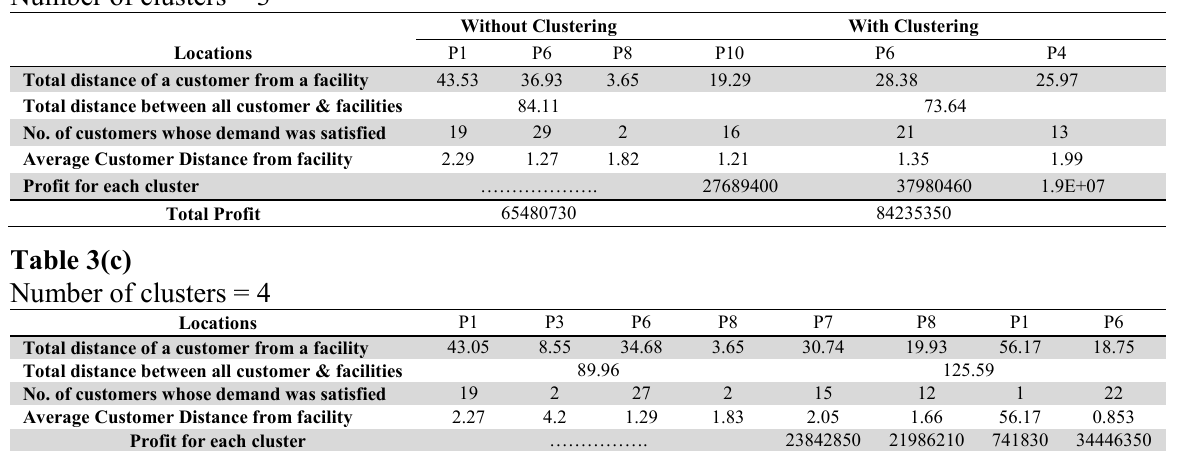
Table 3(b) Number of clusters = 3